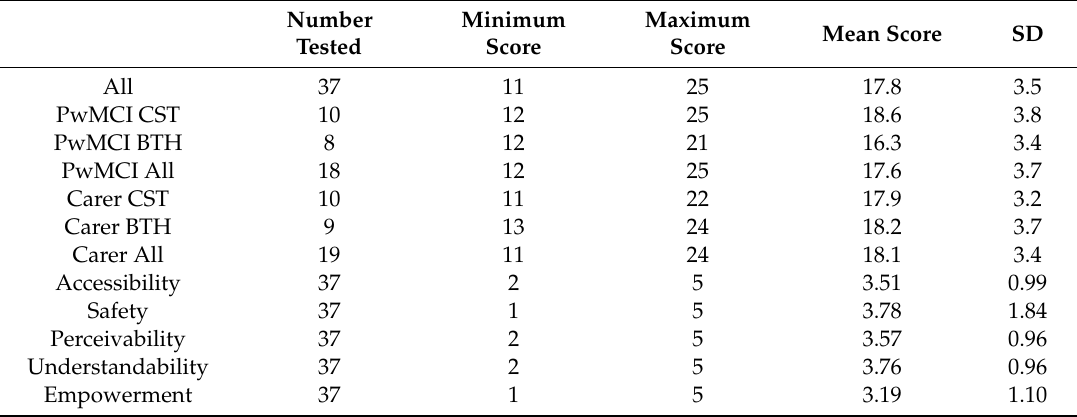
Table 4. User evaluation